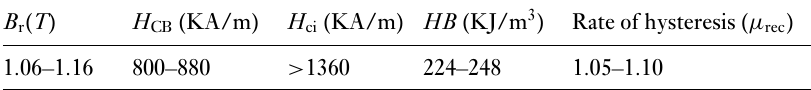
Table 1 Main parameters of Nd 15 Fe 77 B